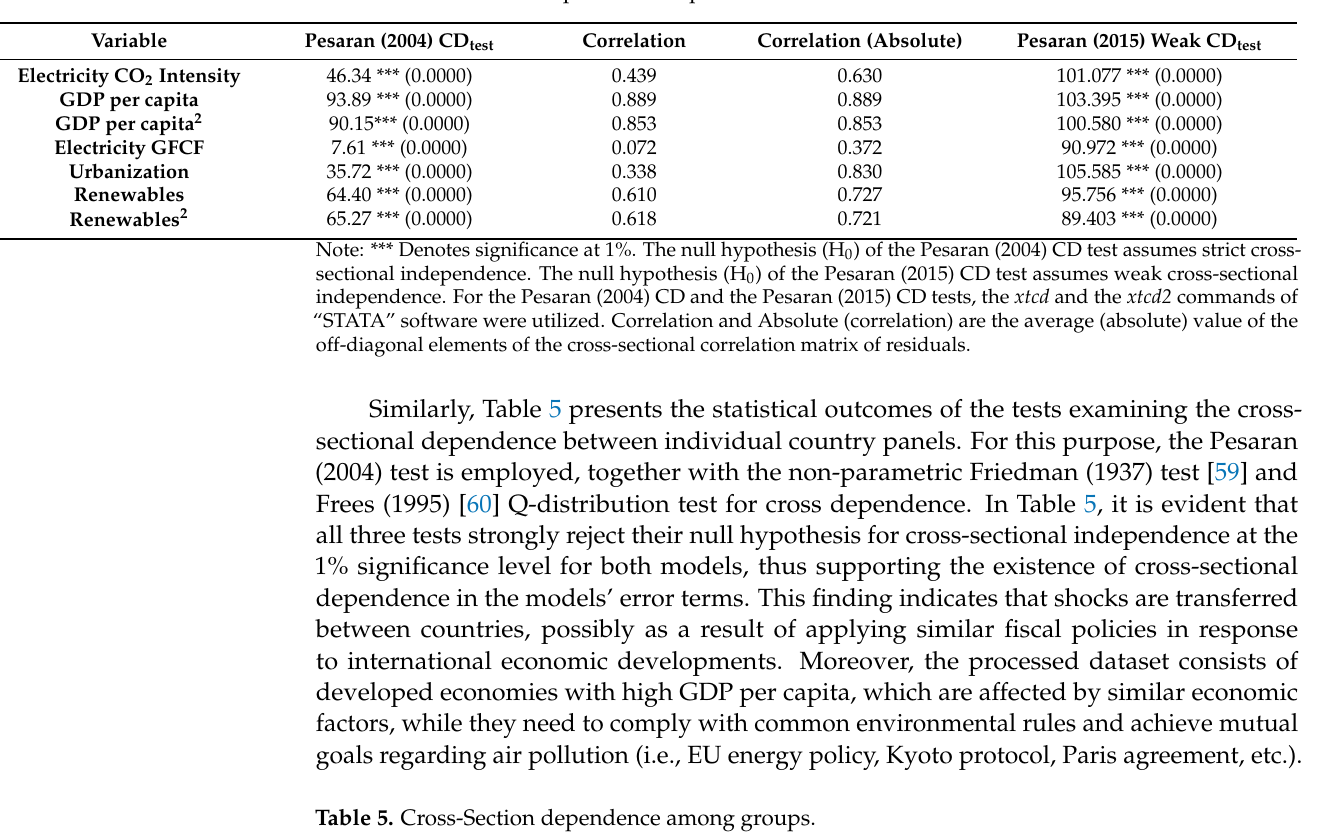
Table 4. Cross-section dependence of panel time series.